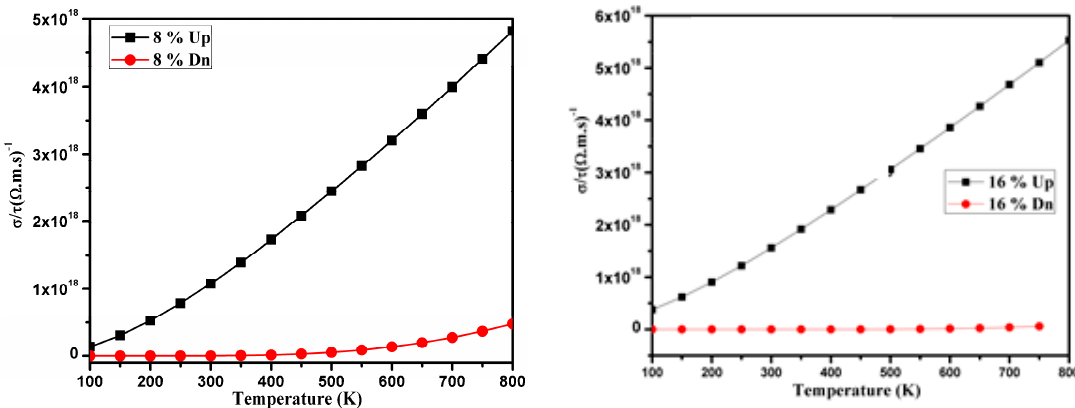
Figure 11. Electrical conductivity (long solid curve-black color for up) and (long solid curve-red color for down) for Mn x Zn 1 − x Te (x = 8% and 16%) versus temperature.